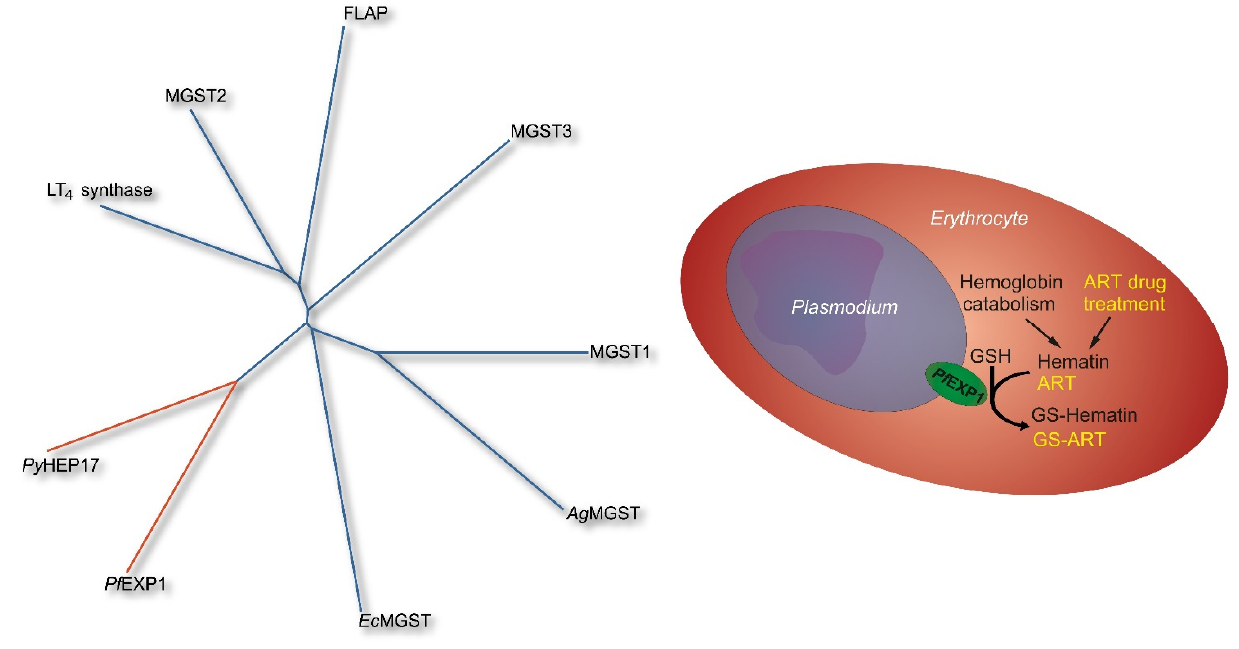
FIGURE 1: (Left) Representative dendrogram of the MAPEG superfamily including the malaria parasite GSTs Plasmodium yoelii HEP17 ( Py- HEP17) and Plasmodium falciparum EXP1 ( Pf EXP1), Escherichia coli MGST ( Ec MGST), Anopheles gambiae MGST ( Ag MGST), rat MGST1, and human MGST3, 5-lipoxygenase activating protein (FLAP), MGST2, and leukotriene C4 synthase. (Right) Proposed model of Pf EXP1 in Plasmo- dium falciparum infected erythrocytes. The membrane protein Pf EXP1 catalyzes the conjugation of reduced glutathione (GSH) onto hematin and onto the drug artemisinin (ART) and thus contributes to their